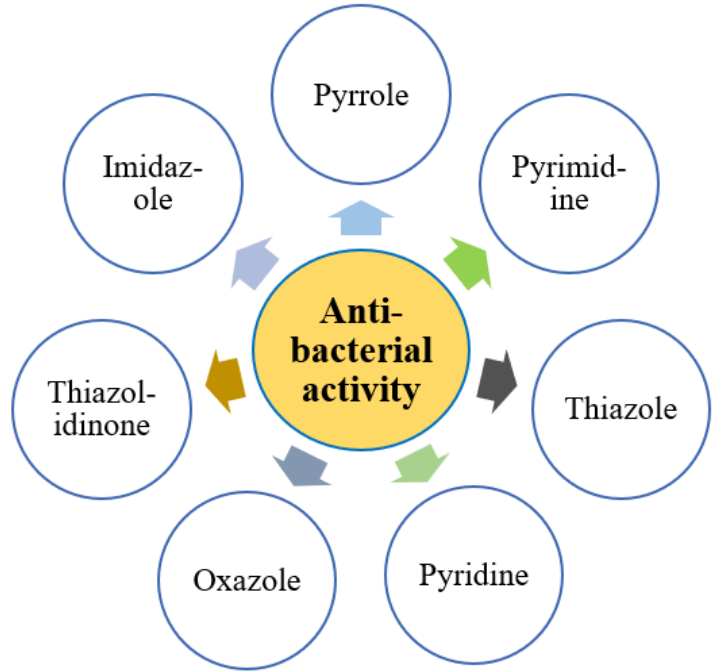
Figure 1. Literature survey of antibacterial activity of nitrogen-based heterocyclic